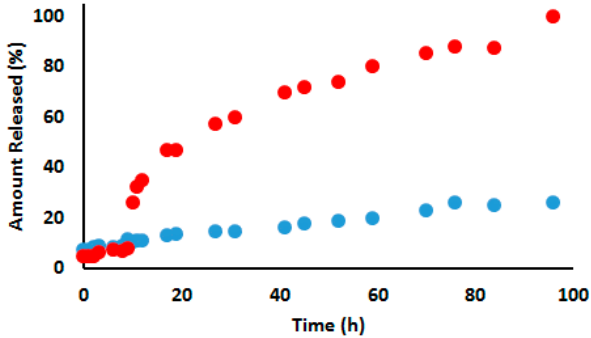
Figure 4. Release profile of TCPP-EtSH from RR-TCPP-PSilQNPs incubated in the presence ( red circles ) and the absence ( blue circles ) of the reducing agent dithiothreitol. Dithiothreitol (DTT) was added at time equal 9 h.